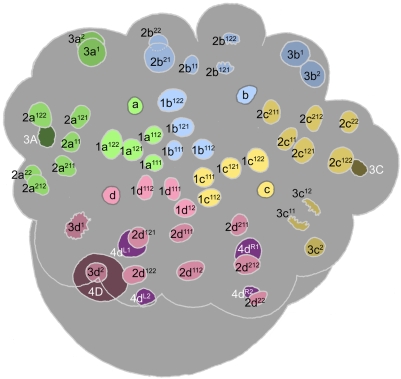
59-cell embryo, 635 minutes.Both 3c1 and 3d1 are in mitosis; the granddaughters of 2acd have completed their divisions, while 2b12 is just completing its division and 2b21 is still in interphase. The daughters of 4dLR have reformed interphase nuclei, showing the same pattern of asymmetric division on both sides.